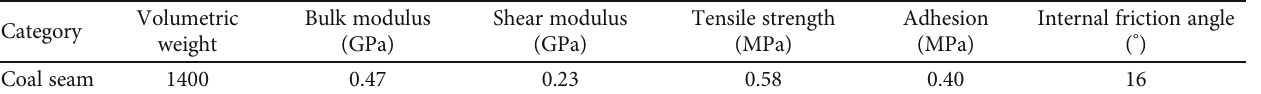
Figure 4: Relationship curves of permeability and gas pressure and overburden pressure in di ff erent diameter boreholes. Table 2: Physical-mechanical parameters of the coal body.